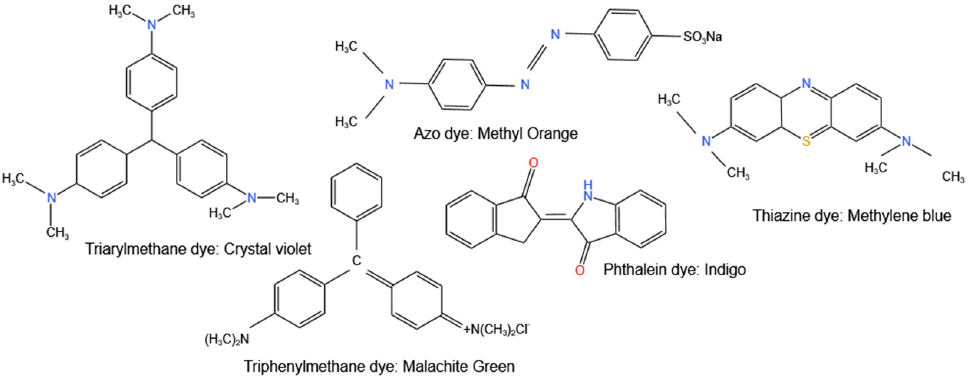
Figure 6. Classification of some organic dyes using their chromophores.